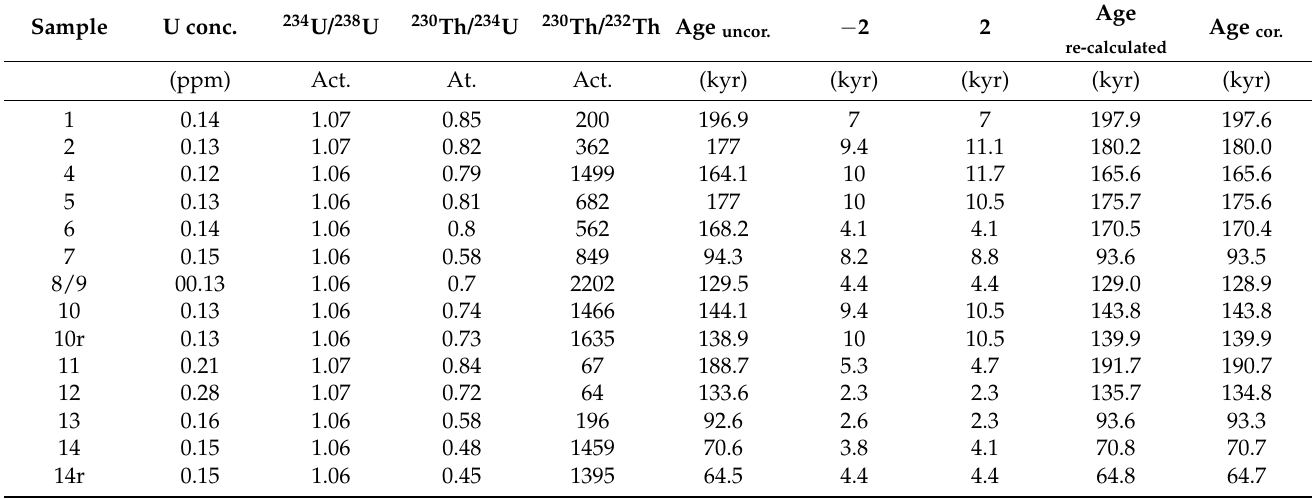
Figure A3. U-Th ages vs . the sampling depth of the flowstone DWBAH (redrawn from [1]). Table A1. Ages of the flowstone DWBAH [11] corrected for the detrital 230 Th component. Age re-calculated represents the age re-calculated using the most recent 230 Th, 234 U, and 238 U decay constants of [72,73]. Age cor. represents the age corrected for the detrital 230 Th fraction using an initial 230 Th/ 232 Th activity ratio of 0.8 ± 0.8, as suggested by [75] for the speleothems from the